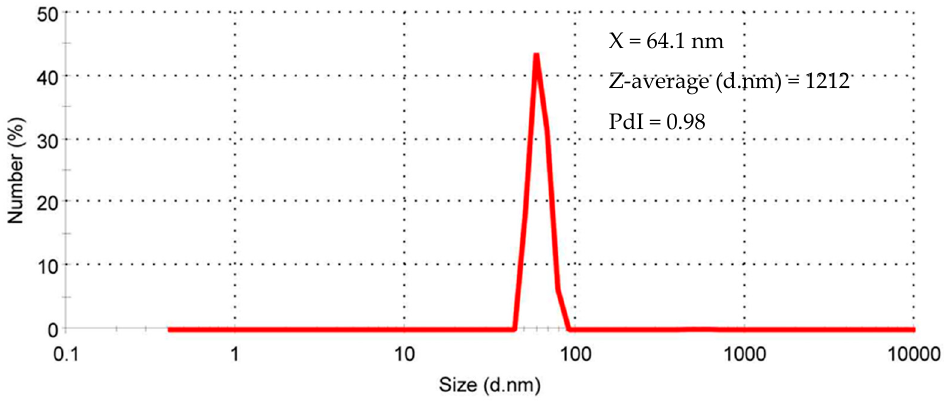
Figure 8. PSD of the as-fabricated NiS nanoparticles with the PCS analysis.